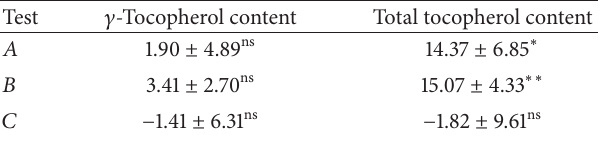
∗ and ∗∗ :significantat 𝑃 < 0.05 and 𝑃 < 0.01 probabilitylevels,respectively. ns = not significant.